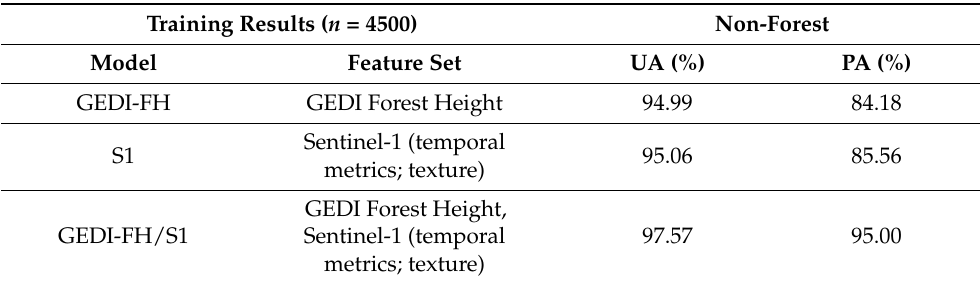
Table 3. Training accuracies of non-forest class generated using the GEDI-FH, S1, and GEDI-FH/S1 models. All masks are generated from the RF probability output at a PT of